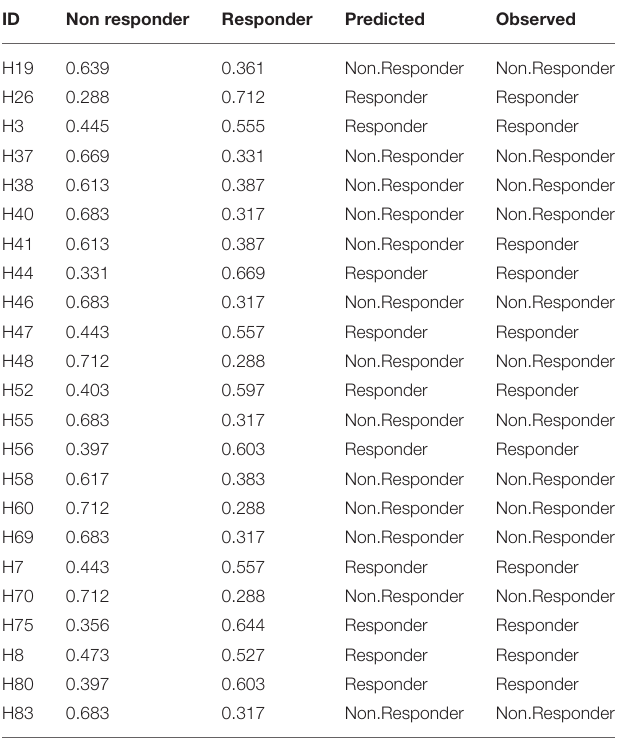
Predicted and observed outcome are listed for all patients.